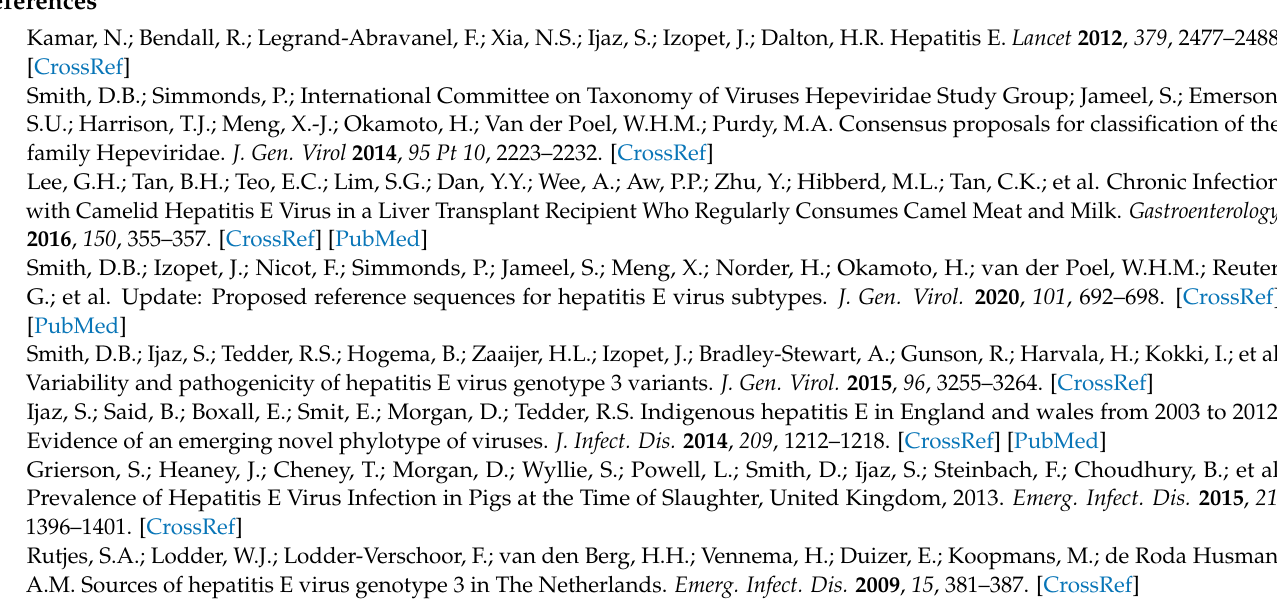
Figure 2. Summary of the difference in subgenotype distribution of HEV isolated from pigs and humans over time. The percentage of HEV sequences from each subtype from pig and human HEV was calculated from Table 1.